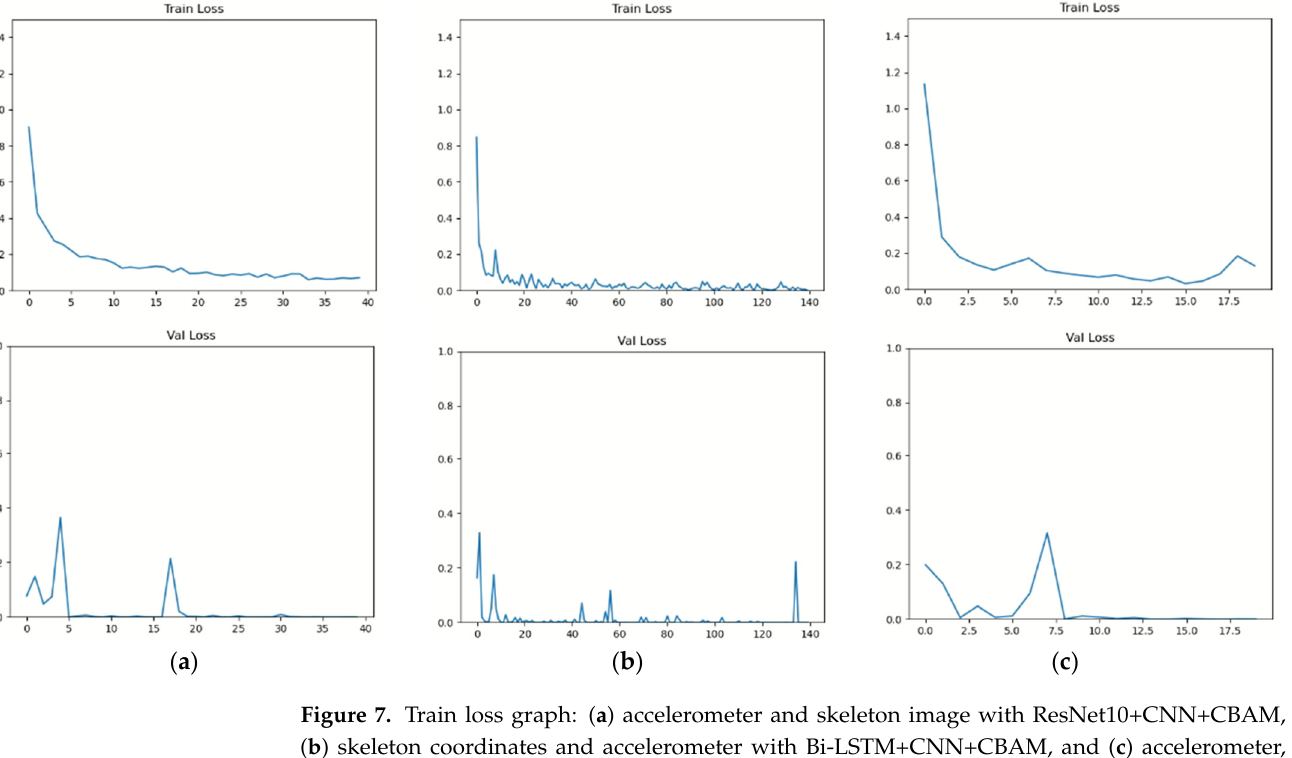
13 of 19 Figure 6. Confusion matrix of activity classification: ( a ) sensor-only confusion matrix, ( b ) accelerom- eter and skeleton image, ( c ) skeleton coordinates and accelerometer, and ( d ) accelerometer, skeleton vector, and skeleton image. The performance, analyzed in terms of time is shown in Figure 7 and Table 1. Figure 7 shows the train loss and validation loss of our proposed method. To avoid overfitting, we used train loss and validation loss to generate optimal parameters. The moment where